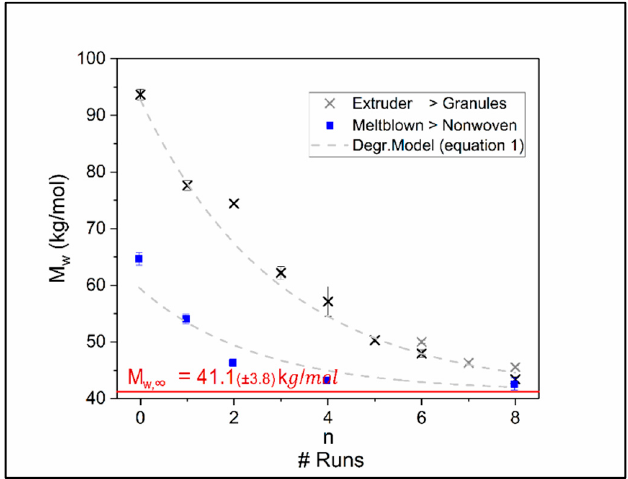
Figure 8. Decrease of M w as a function of recycling runs for the material of the recycling study (crosses) and the nonwoven made out of it (rectangles). The dashed lines are the best adjustment of Equation (1).